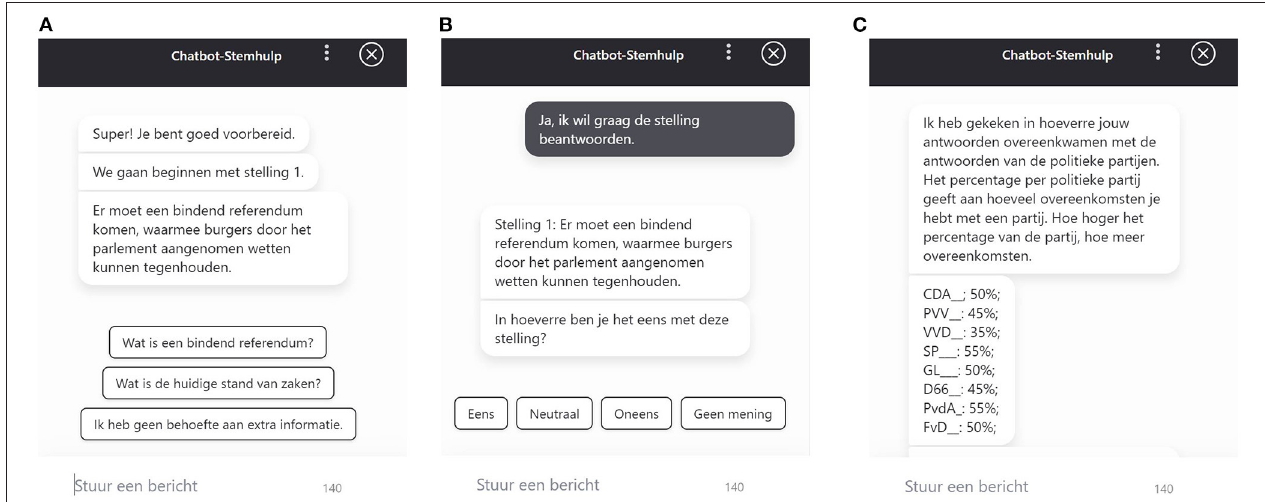
FIGURE 1 | (A) Example of a CAVAA statement ( We will start with statement 1. There should be a binding referendum with which citizens can stop laws being implemented ), three buttons ( What is a binding referendum , What is the current state of affairs , and I do not need additional information ), and a text-entry functionality to request specific information. (B) Example of a CAVAA statement and response options ( There should be a binding referendum with which citizens can stop laws being implemented . To what extent do you agree with this statement? Agree, Neutral, Disagree, No Opinion ). (C) Example of the CAVAA voting advice ( I have checked to what extent your answers match with the answers of political parties. Below you can find the percentage of agreement with each political party. The higher the percentage, the more similar answers you have provided as the political party mentioned